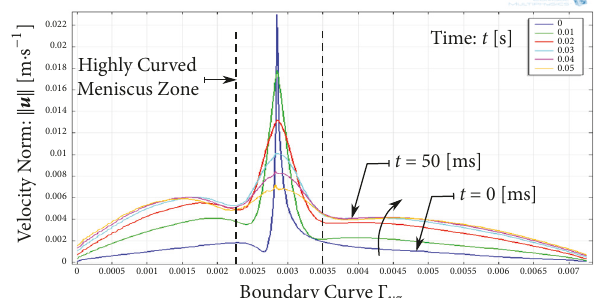
Figure8:Timeevolutionofthevelocitynorm ‖ u ‖ oftwointeracting droplets with radii 𝑅 1 , 𝑅 2 (with 𝑅 2 = 𝑅 1 ) along the boundary curve Γ 𝑦𝑧 for the sequence of times